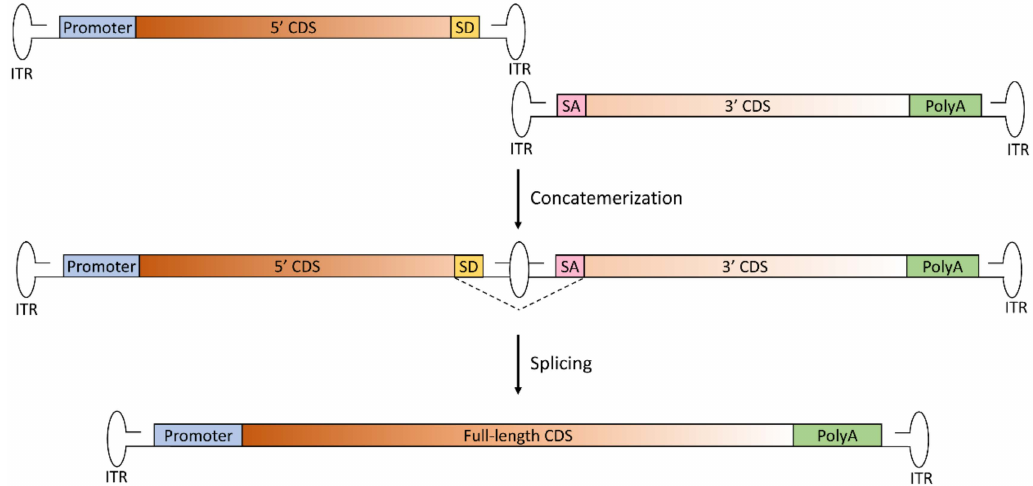
Figure 1. Schematic representation of the trans-splicing dual AAV approach for large gene reconstitution. The first vector includes the promoter, the 5’-half of the coding sequence (CDS) and the splicing donor (SD) signal; the second vector includes the splicing acceptor (SA) signal, the 3’-half of the CDS and the polyadenylation signal (PolyA). Concatemerization of the two vectors, involving the right-hand inverted terminal repeat (ITR) of the first vector and the left-hand ITR of the second vector, reconstitutes the full-length gene. After transcription, splicing leads to the removal of the ITR structure at the junction point, with restoration of the full-length, mature RNA of the